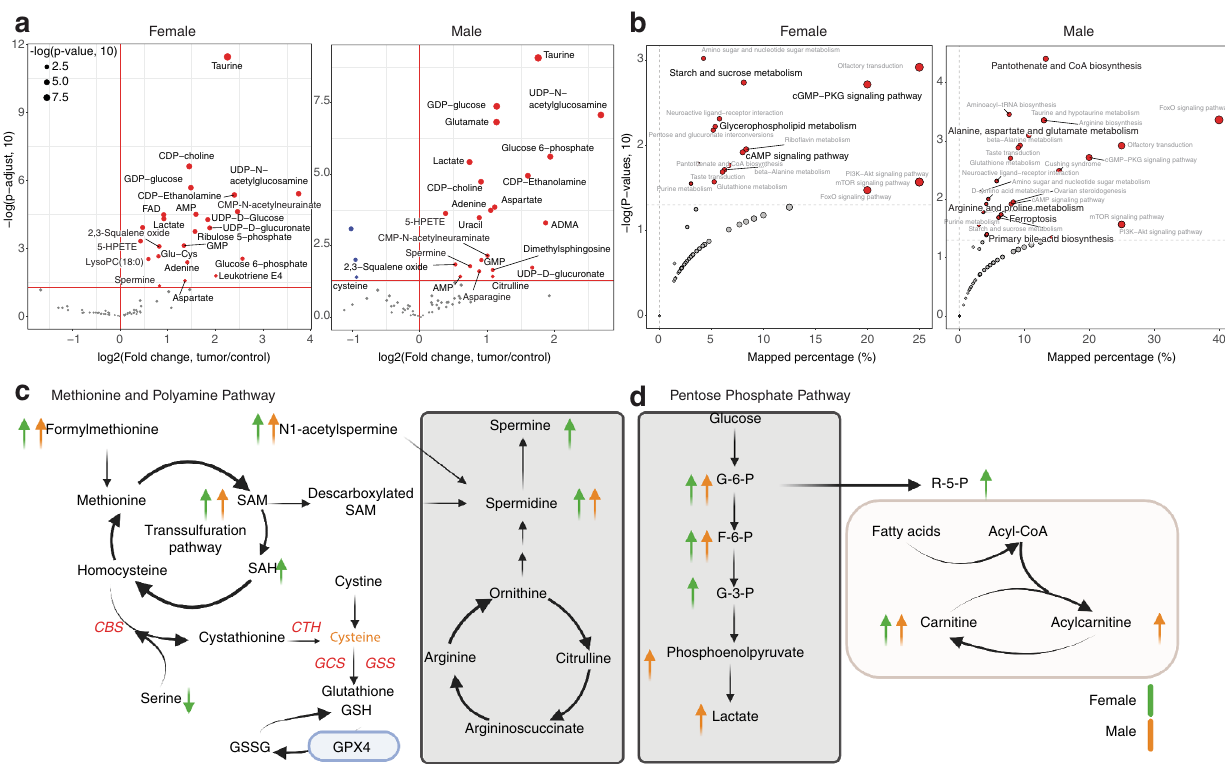
Fig. 4 | Biological function mining for the case study. a Volcano plots show the differentially expressed metabolites. b Pathway enrichment analysis. Only the pathways that are different between sexes were labeled. Sex differences